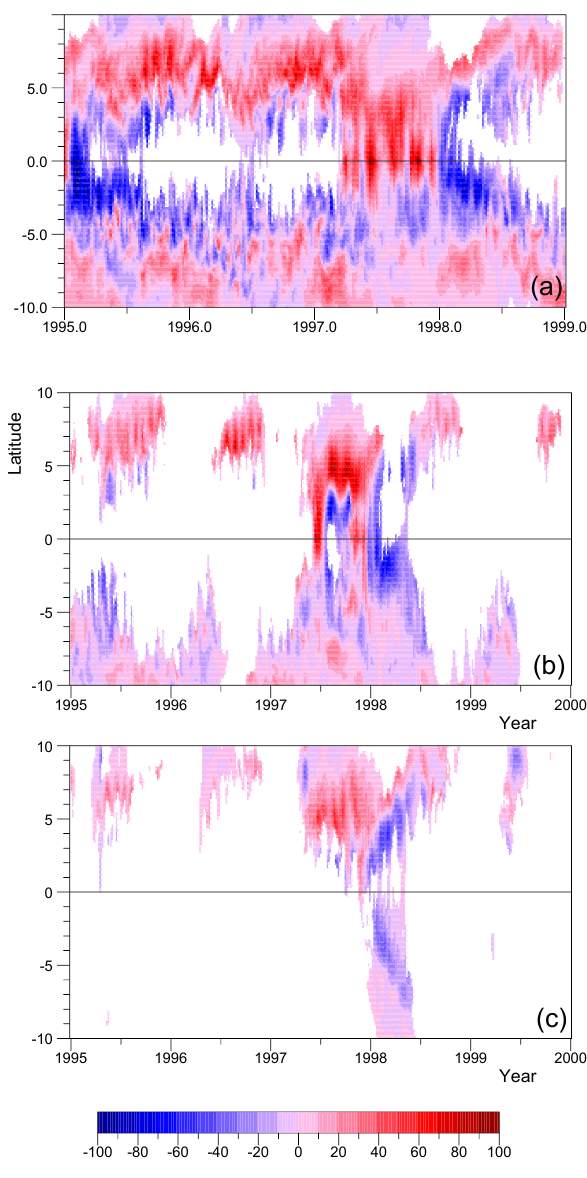
Figure 28. Vertically integrated flux of water (m 2 s − 1 ) with temper- ature (a) greater than 28 ◦ C crossing longitude 180 ◦ E, (b) greater than 28 ◦ C crossing 210 ◦ E and (c) greater than 28 ◦ C crossing 240 ◦ E. The figure is blank where the flux is